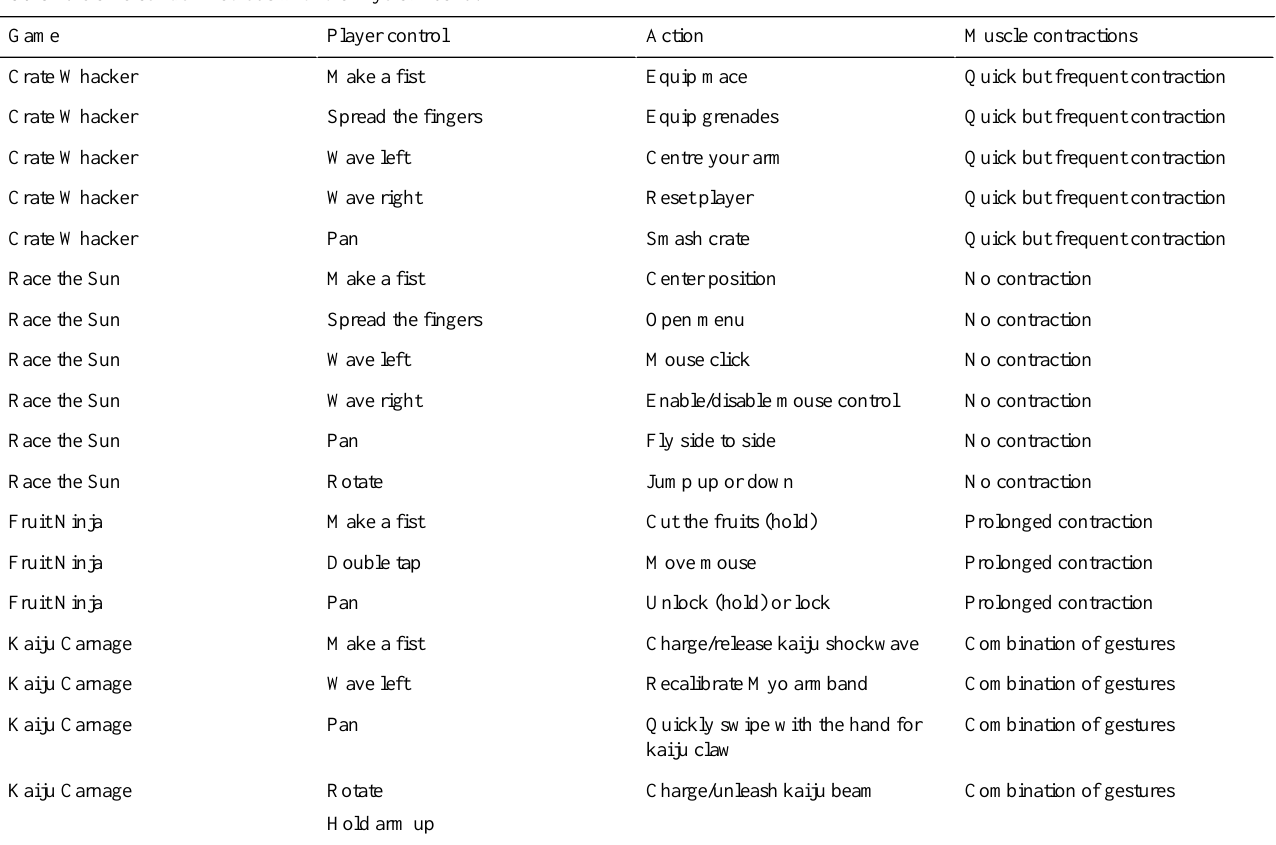
Table 1. Game control methods with the Myo